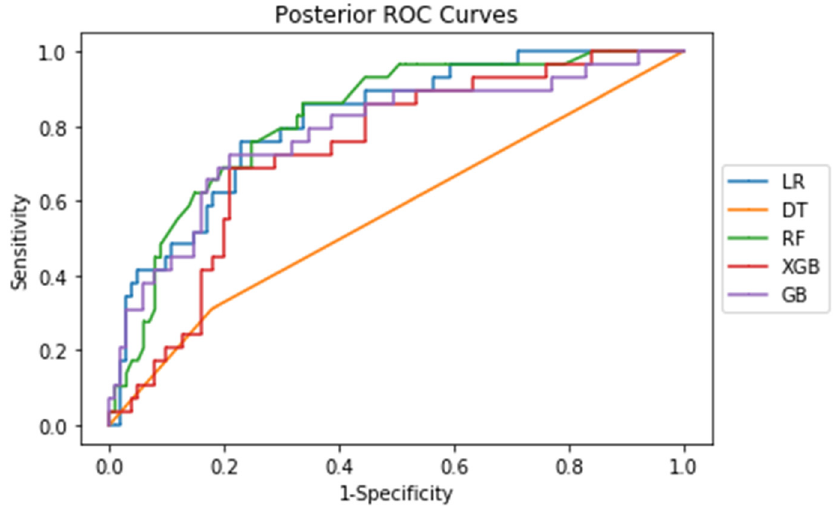
Figure 2. ROC curves of the five machine learning algorithms for posterior cases.